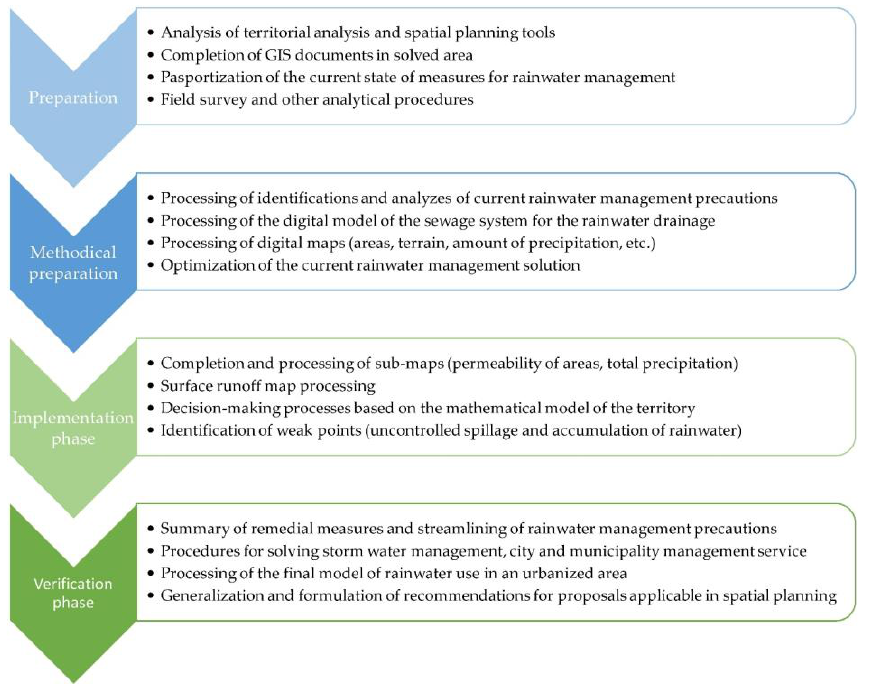
Figure 2. Application process of the R-WIM tool (source: author).